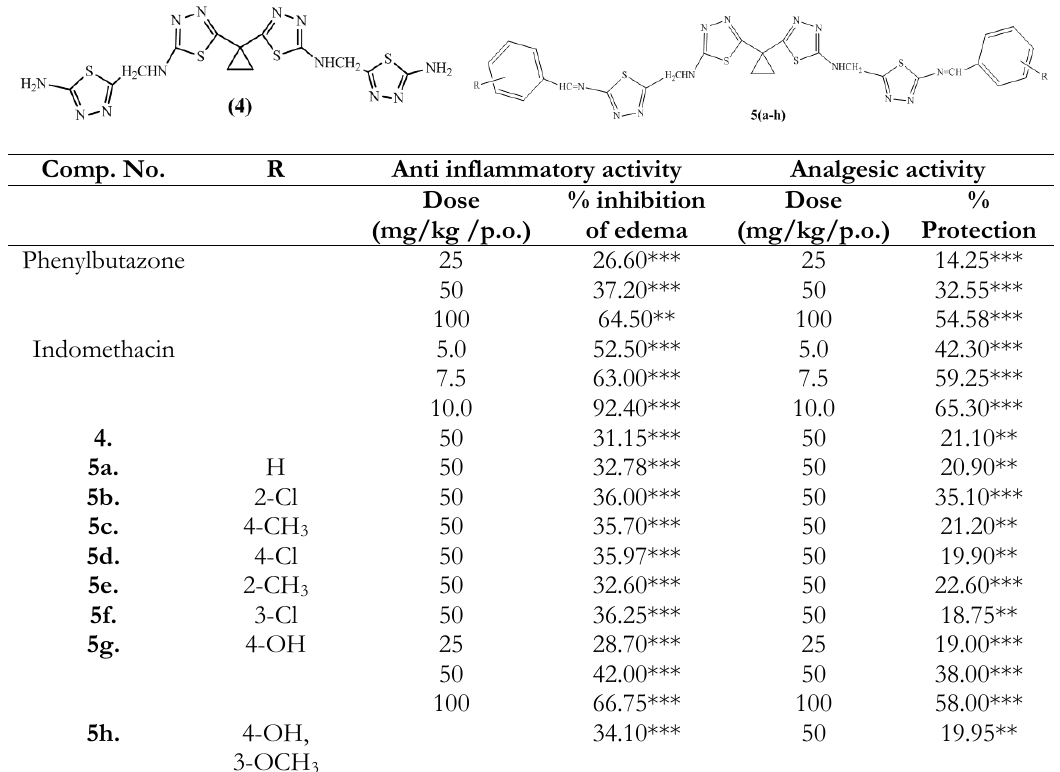
Table IIa. Antimicrobial data for the synthesized compounds 4 and 5(a-h).